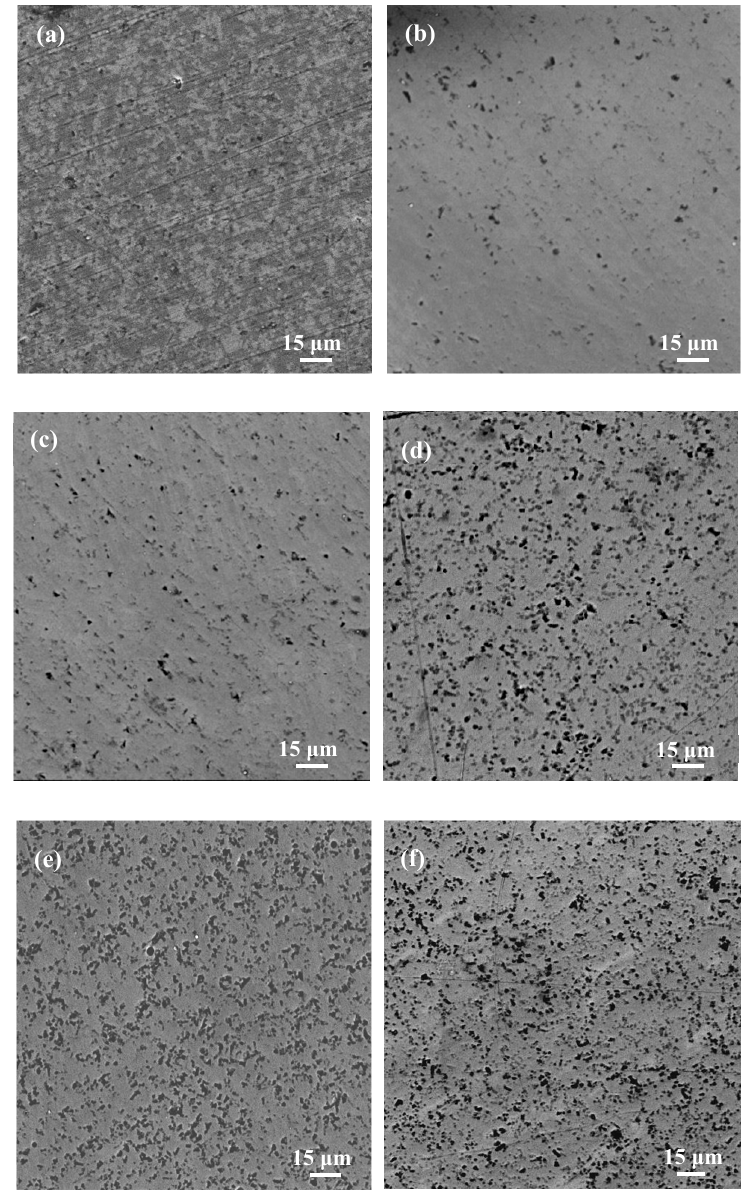
Figure 2. Surface morphologies of the composite coatings with different Zr current ( a ) 0 A; ( b ) 30 A; ( c ) 45 A; ( d ) 60 A; ( e ) 80 A; ( f ) 100 A.